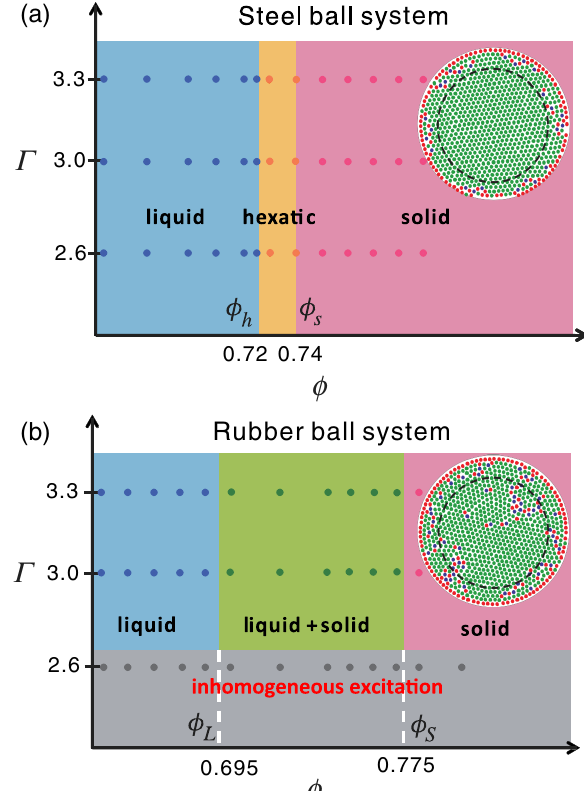
FIG. 9. Phase diagram of driven monolayer sphere systems. Filled circles represent state points where the measurements are made (blue, disordered liquid; orange, hexatic phase; pink, solid; green, a coexistence of liquid and solid; gray, no well-defined stationary state due to inhomogeneous excitation). (a) Steel ball systems, which obey the KTHNY-like scenario. In this case, the state behavior does not depend on Γ in the range studied. (b) Rubber ball systems, which show the distinct discontinuous transition between liquid and solid states. In this case, the dynamical steady state is realized only above Γ ≅ 2 . 7 . This higher threshold value of Γ is presumably due to the inelastic nature of collisions of rubber balls with the confining plates. The images in (a) and (b) are configurations in the solid phase at ϕ ¼ 0 . 78 for steel and rubber ball systems, respectively. Green, blue, and red particles have local hexagonal, pentagonal, and heptagonal structures, respectively. The inner part surrounded by the red dashed circle has less order (i.e., more defects) for the rubber ball system than for the steel